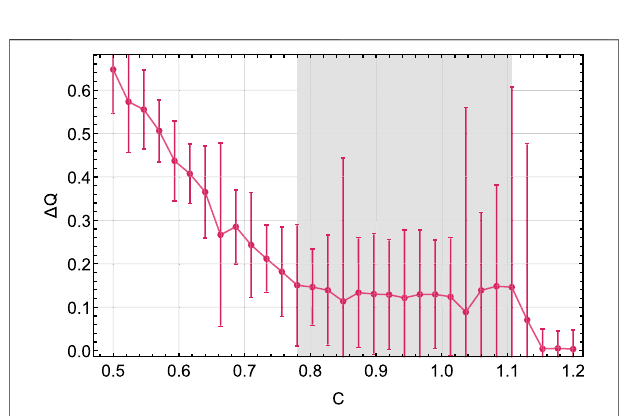
FIGURE 7 | Δ Q (cid:1) Δ W + Δ U as a function of C for the values obtained in Figure 6 , the shaded area corresponds to the region where there is a step on the plot of ρ , passing through ρ (cid:1) 0 .